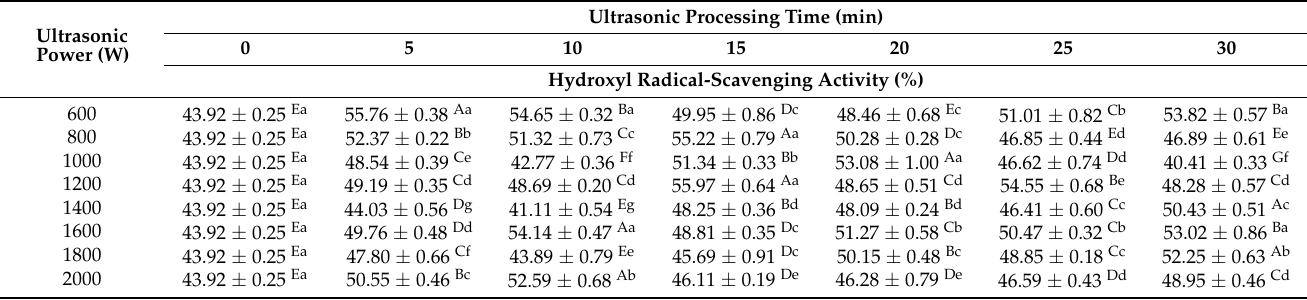
Data are the averages of three replications ± standard deviation. A–G: Different uppercase letters mean significant difference in comparisons between ultrasonic processing time (0, 5, 10, 15, 20, 25, and 30 min) for each power at p < 0.05. a–g: Different lowercase letters mean significant differences between ultrasonic power (600, 800, 1000, 1200, 1400, 1600, 1800, and 2000 W) for each processing time at p < 0.05. Table 5. Effect of HIU treatment on DPPH radical-scavenging of the WPI hydrolysates. Ultrasonic Processing Time Ultrasonic Power (W)